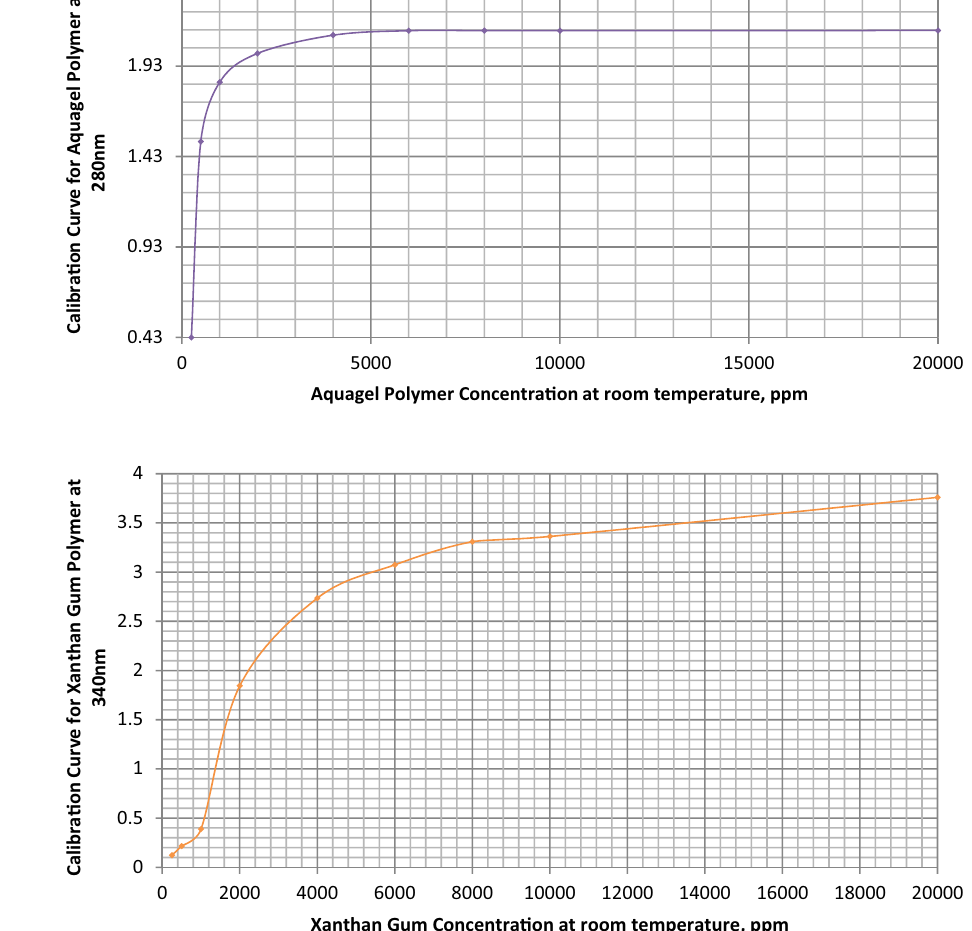
Fig. 5 Aquagel polymer calibra- tion curve at a 𝜆 max 280 nm